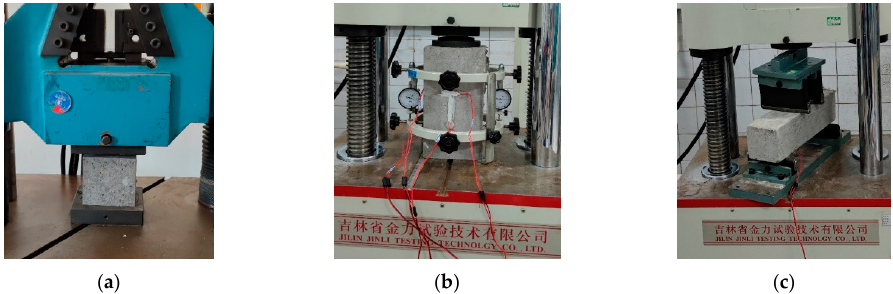
Figure 3. Basic mechanical tests. ( a ) Compression test; ( b ) Young’s modulus test; ( c ) Flexural